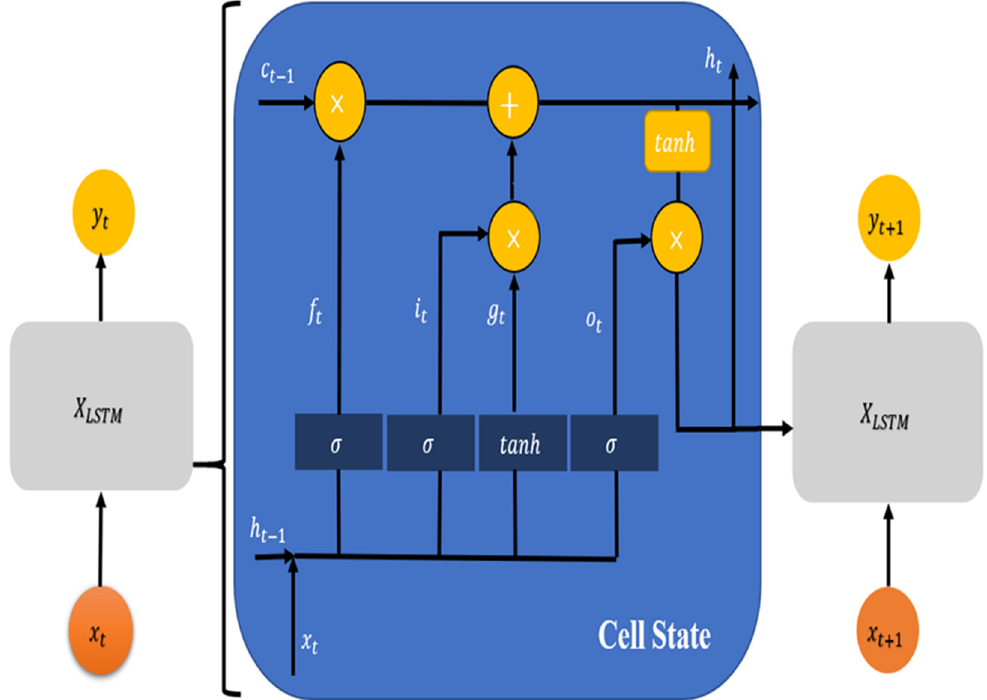
Figure 2. The architecture of the long short-term memory (LSTM) cell state (‘X’), where x t and y t are the target variables before and after passing through the network at the current gate, respectively; x t +1 and y t +1 are the target before and after passing through the network at the next iteration, respectively.